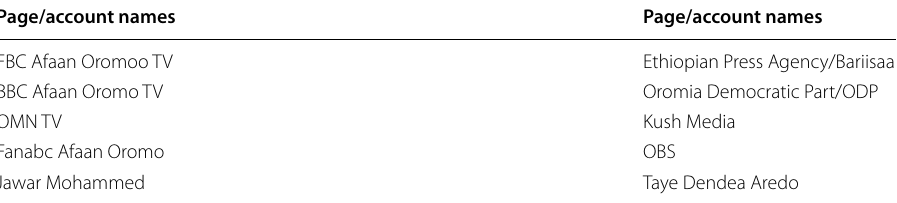
Table 1 Summary of public pages to retrieve comments and posts from Facebook and twit from Twitter